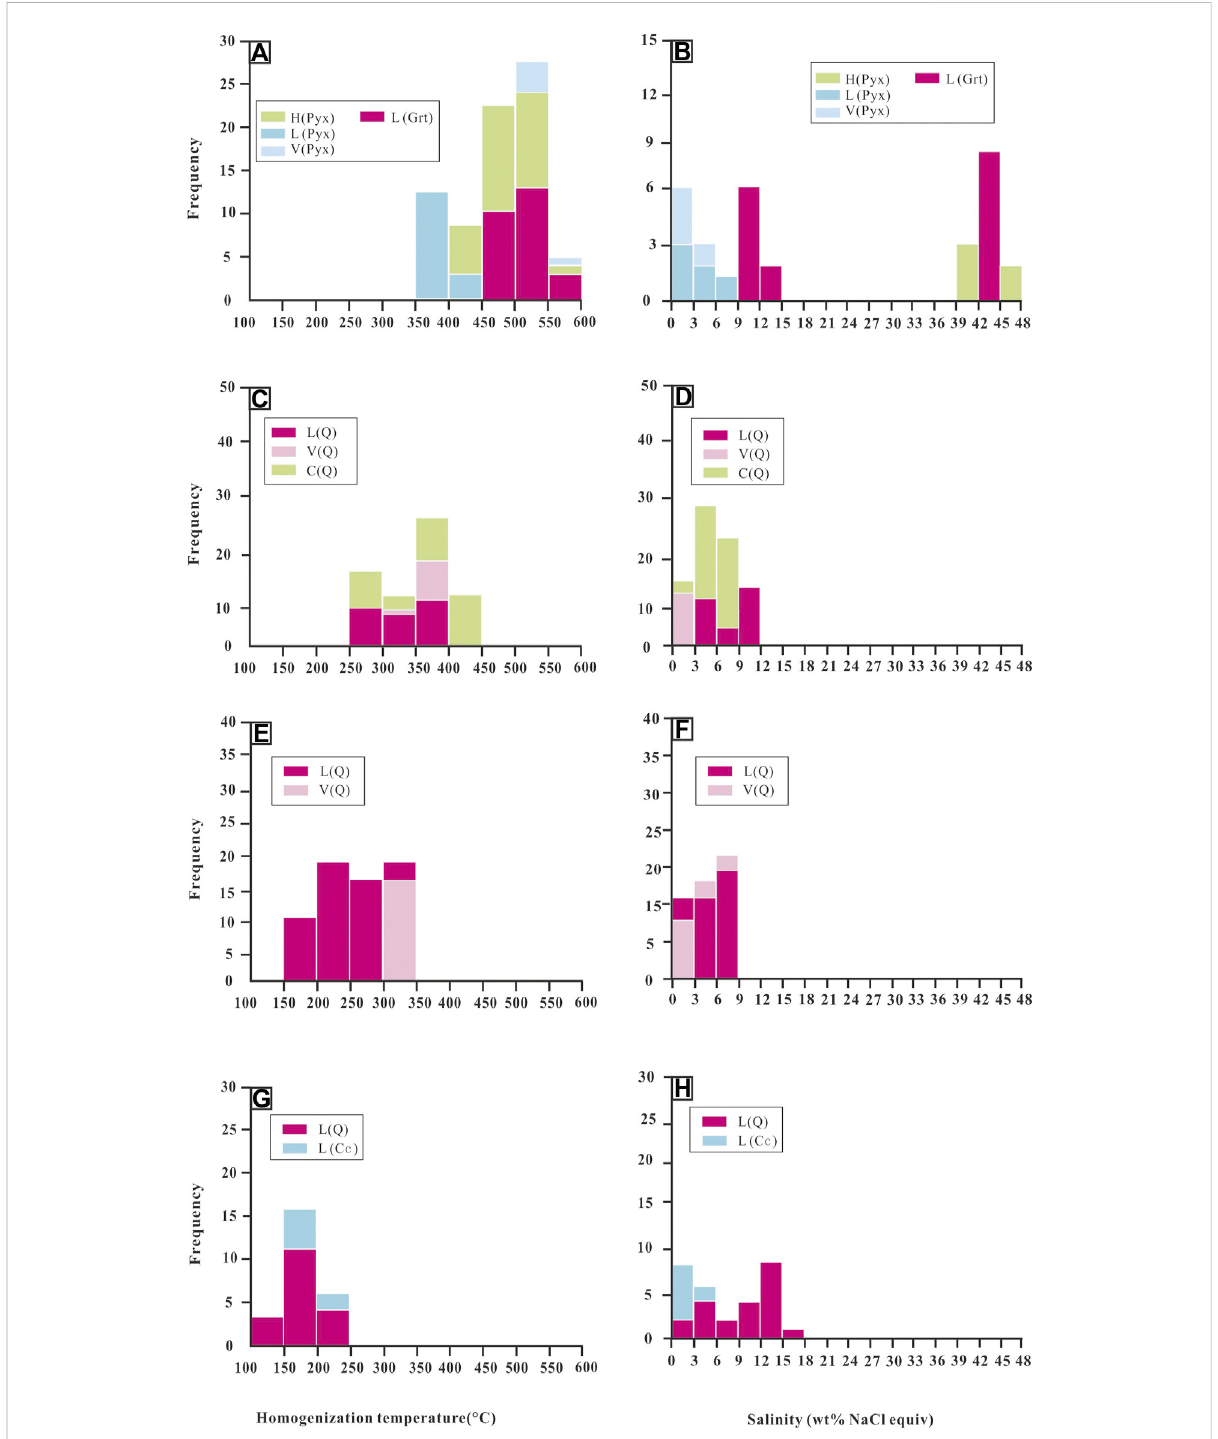
FIGURE 9 Histograms of homogenization temperatures and salinities for all inclusion types in the Shibaogou Mo – Pb – Zn deposit; (A,B) variations of homogenization temperatures and salinities in the anhydrous skarn stage; (C,D) variations of homogenization temperatures and salinities in the hydrous skarn stage; (E,F) variations of homogenization temperatures and salinities in the quartz – sul fi de stage; and (G,H) variations of homogenization temperatures and salinities in the carbonate stage.